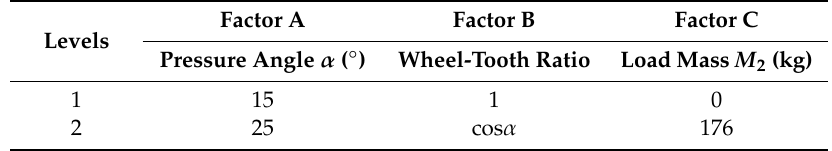
Figure 11. Definition of vibration attenuation time. Table 3. Three factors and two levels of the